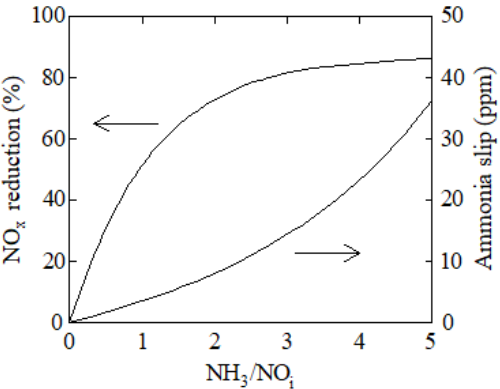
Figure 6. NO x reduction against the NH 3 /NO i ratio. Start of ammonia injection 43.2º, 10º injection duration, rectangular injection shape.